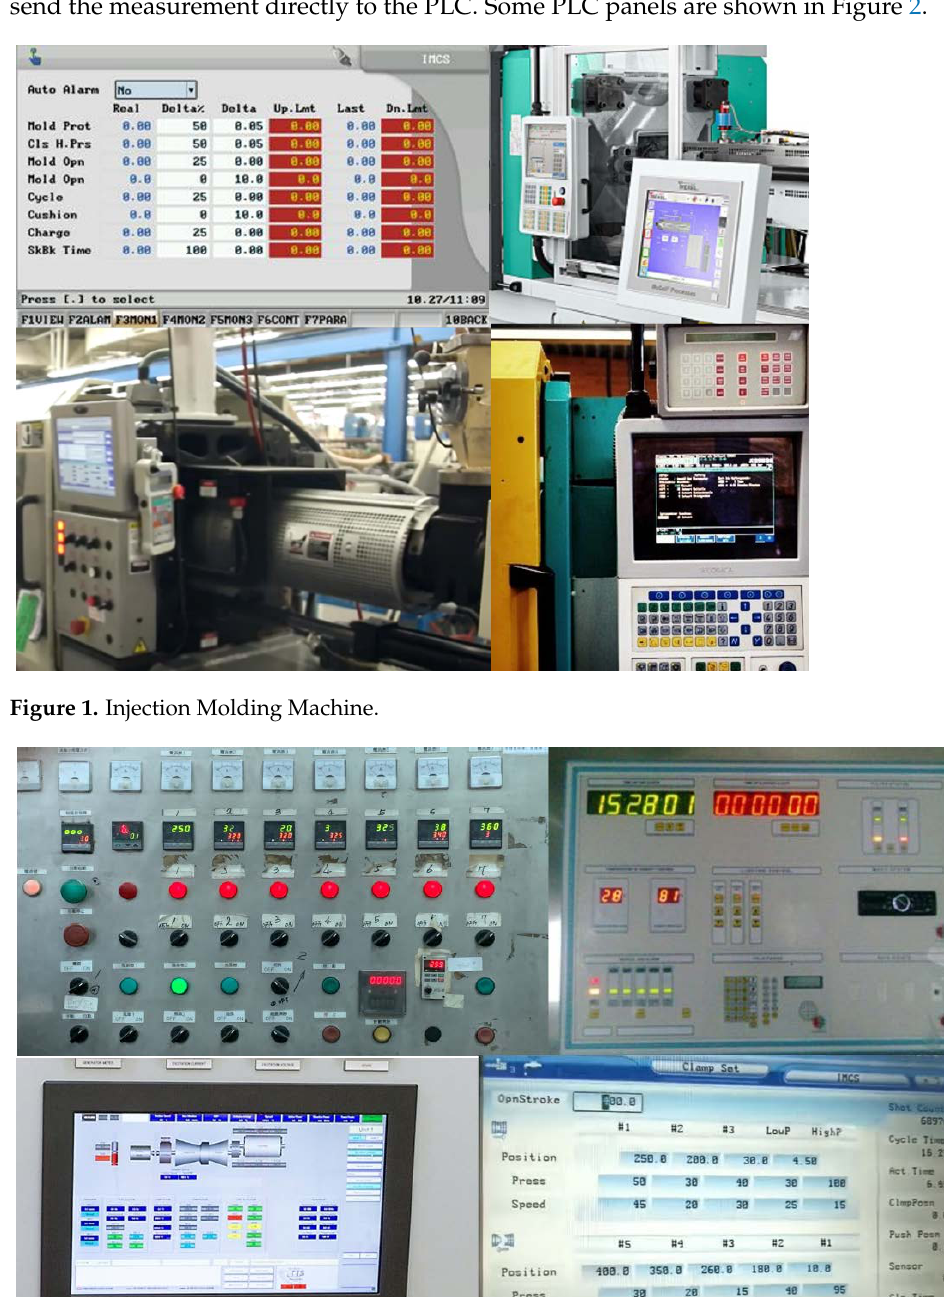
Figure 1. Injection Molding Machine.